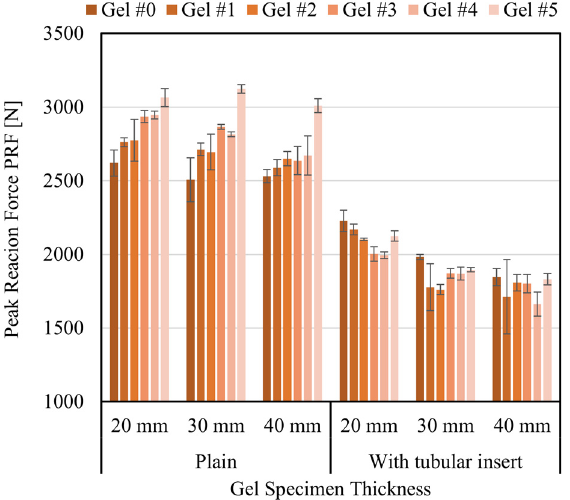
Figure 10. Compilation of average PRF values. The top error bars correspond to the standard devi- ation.